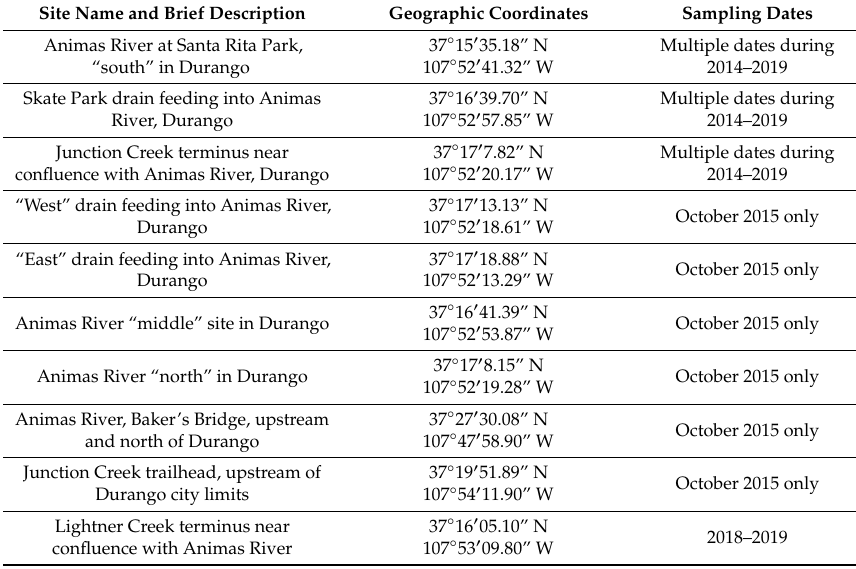
Figure 1. Water sampling sites on the Animas River, studied August 2014–February 2015. Santa Rita Park is located downstream of the skateboard park and Junction Creek. See Table 1 for geographical coordinates of the sampling sites. The map was created using Durango Maps (gis/durangogov.org). Table 1. Animas River sampling sites studied during 2014–2019. Geographic coordinates were captured at sampling sites using Google Earth software installed on a smartphone.